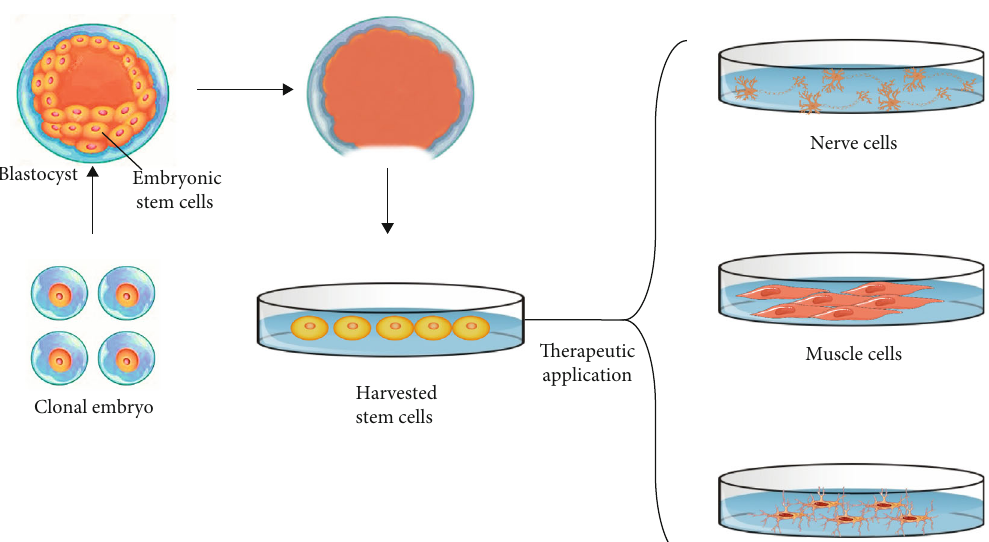
Figure 3: Isolation of stem cells from a preembryo.